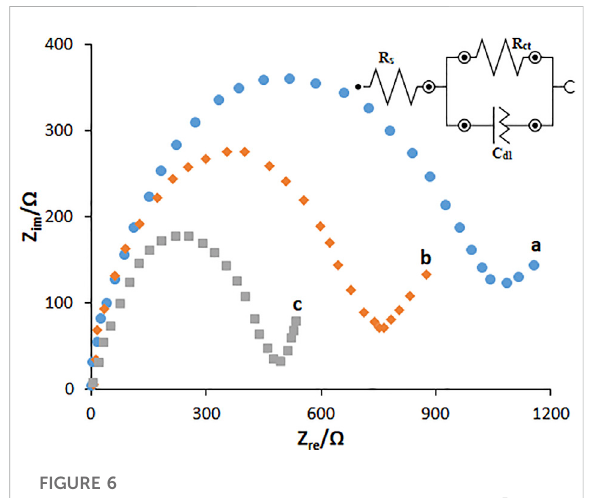
FIGURE 6 EISdiagrams andtheequivalent circuitfor 0.1 mM[Fe(CN) 6 ] 3- solution at (A) BPGE, (B) MWCNT/PGE, and (C) MWCNT/HG-NiO- ND/PGE in aqueous 0.1 M KCl. Frequency ranges from 100 KHz to 0.1 Hz.